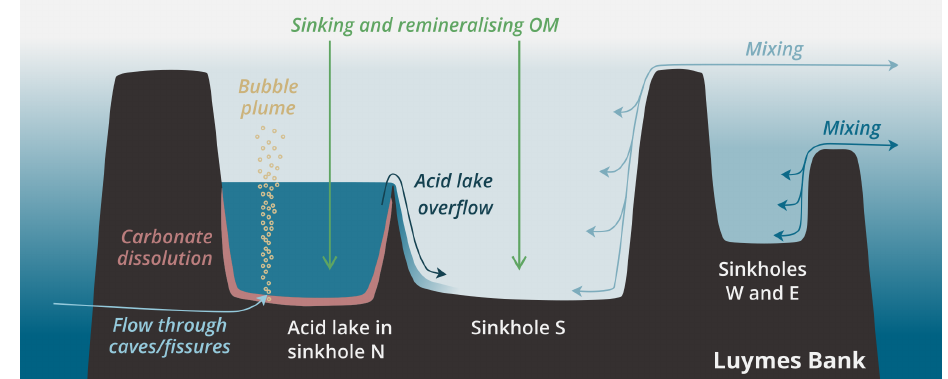
Figure 3. Schematic cross section of Luymes Bank with an overview of the processes acting on seawater as it flows through the sinkholes. Depth range shown is from 0 to ∼ 350m. Background colour represents seawater density, increasing from light to dark